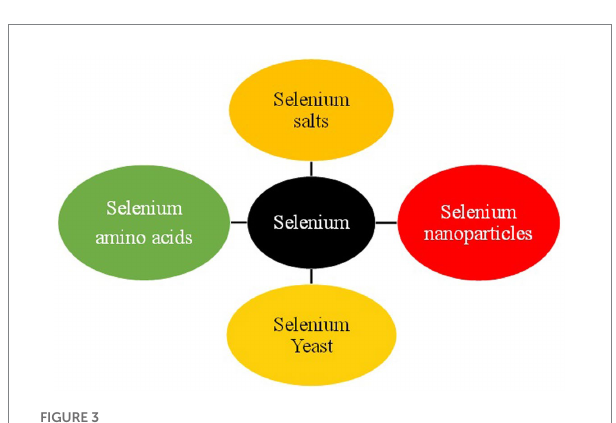
FIGURE 3 Possible ways of Selenium